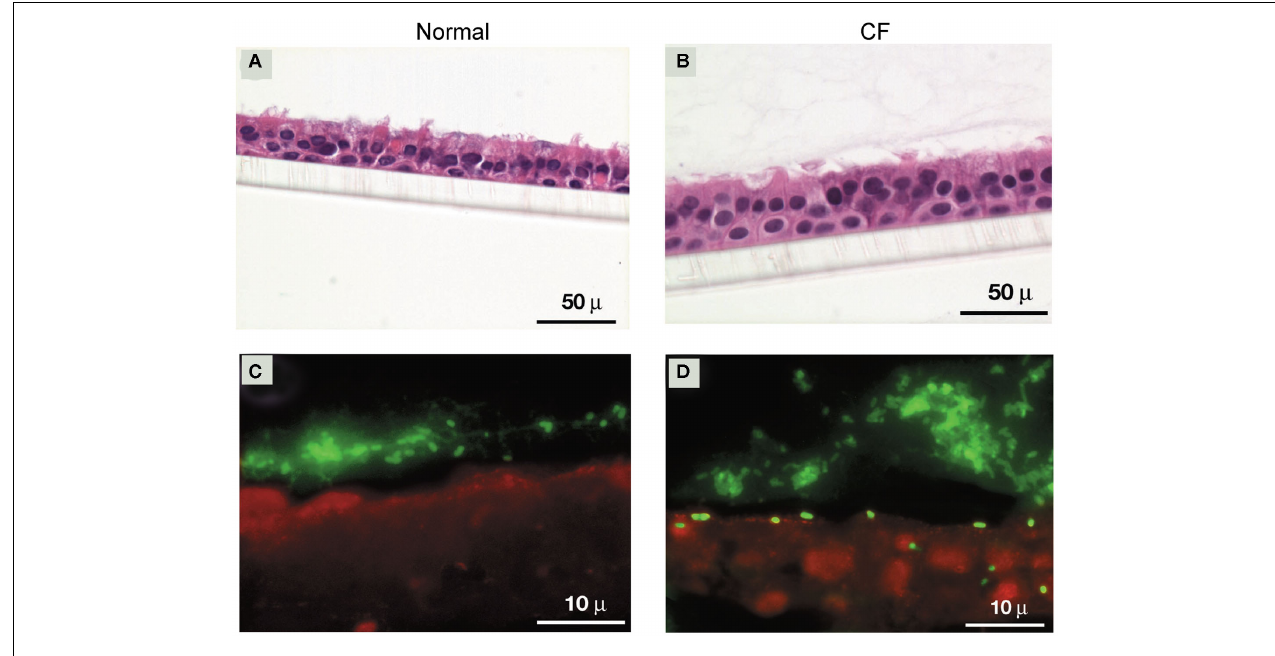
cultures stained with hemotoxylin and eosin. (C,D) Localization of bacteria in normal and CF airway epithelial cells infected with B.